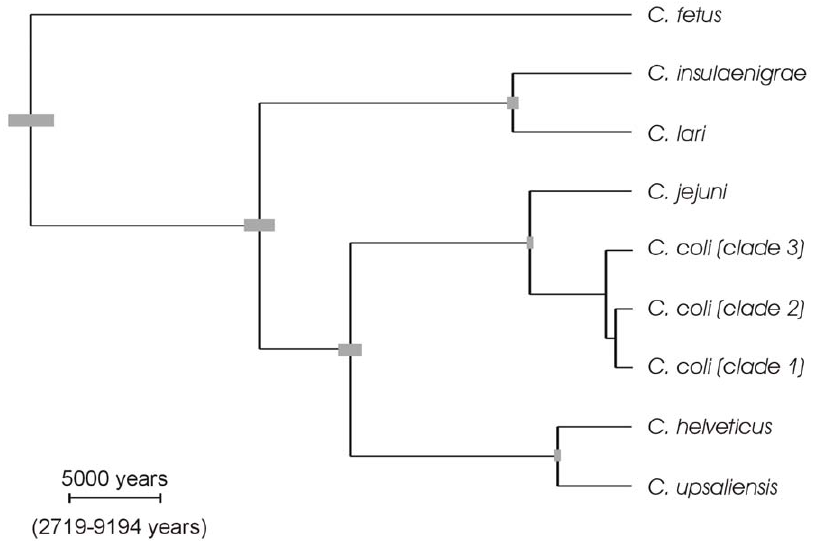
Figure 3. Phylogeny of estimated divergence times in the genus Campylobacter using BEAST. Error bars, in grey, associated with each node indicate relative uncertainty in node height. Calibration of the scale bar was based on intraspecific variation in Campylobacter jejuni and uncertainty associated with the molecular clock calibration is represented by a 95% CI below the scale bar. Empirical and indirect [35] estimates of the rate of molecular evolution would calibrate the same scale bar at 42,200 (95% CI 2,690–661,000) and 7,600,000 years respectively.